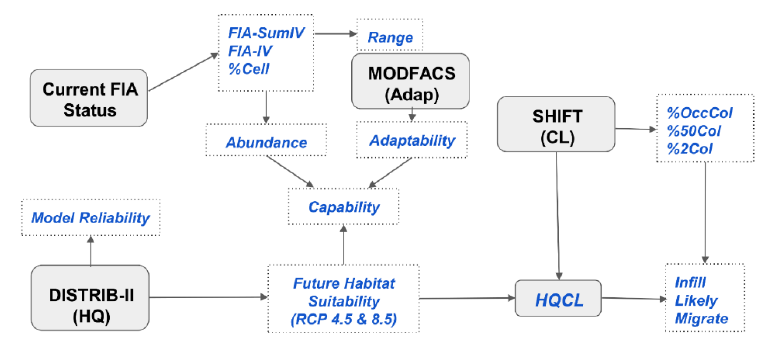
Figure 3. Flowchart depicting workflow for outputs of DISTRIB-II (habitat quality, HQ) and SHIFT (colonization likelihood, CL) to produce capability and candidate species for Infill (the number of species that can be considered likely to expand under a RCP, and thus higher candidates for infill planting), Likely (the species was not found in FIA plots, but there is a relatively high probability that the species exists in the unit), or Migrate (the number of species with at least some chance of migrating naturally into each unit, and thus higher candidates for artificial migration). HQCL is the combination of habitat quality (HQ) and colonization likelihood (CL). %OccCol pertains to the percentage of the unit that is either already occupied or with at least a 50% probability of becoming potentially occupied (according to SHIFT) within 100 years. %50Col (or %2Col) pertains to the percentage of the unit not already occupied that has at least a 50% (or 2%) probability of getting colonized within 100 years.